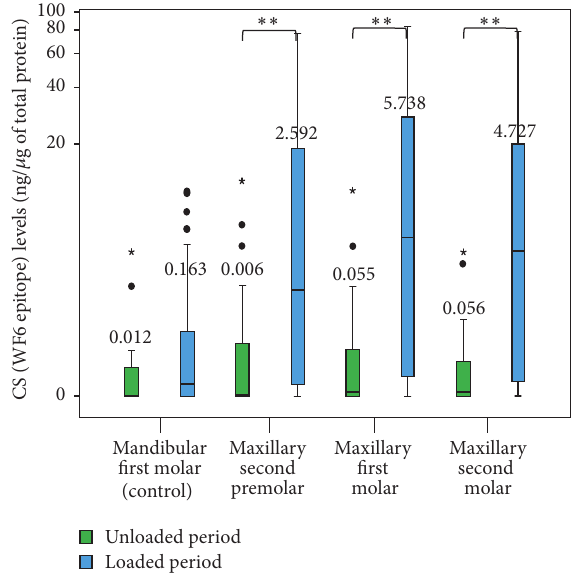
Figure 6: A boxplot graph of the chondroitin sulphate (CS) levels around the mandibular first molar (negative control) and the max- illary second premolar and first and second molars (experimental) during the unloaded and loaded periods. The small circles repre- sent outlier values, and small asterisks represent extreme values. ∗∗ Significant difference: 𝑃 < 0.05 .